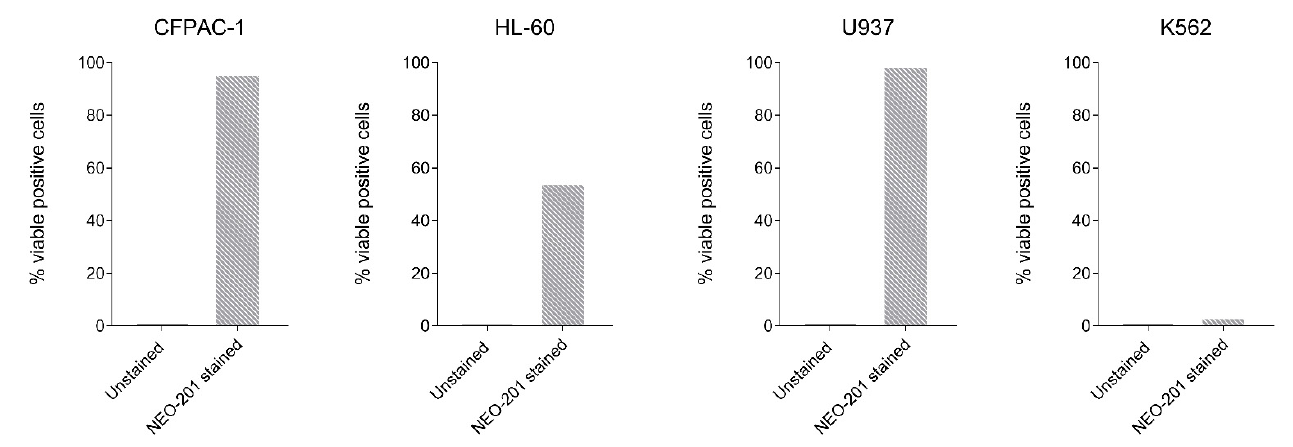
Figure 3. Flow cytometry analysis of the binding of NEO-201 to different cancer cell lines. Graphs depict the percentage of NEO-201 viable positive stained cells compared to the control unstained cells. NEO-201 positivity was defined as % positive cells >10%.